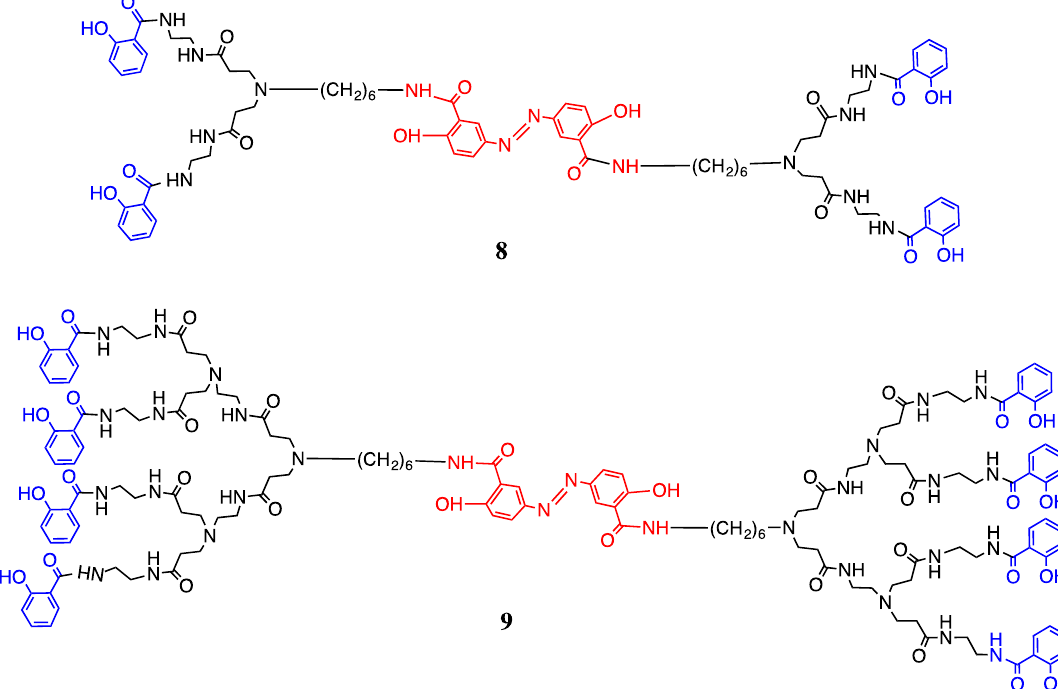
Figure 1. Synthesis of olsalazine-PAMAM-dendrimer-salicylic acid-conjugates of the first (8) and second (9) generation.